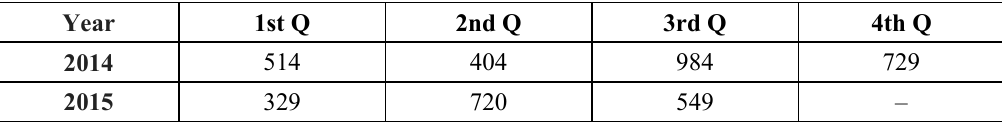
Table 1 . The Number of New Apartments in Latvia (Central Statistical